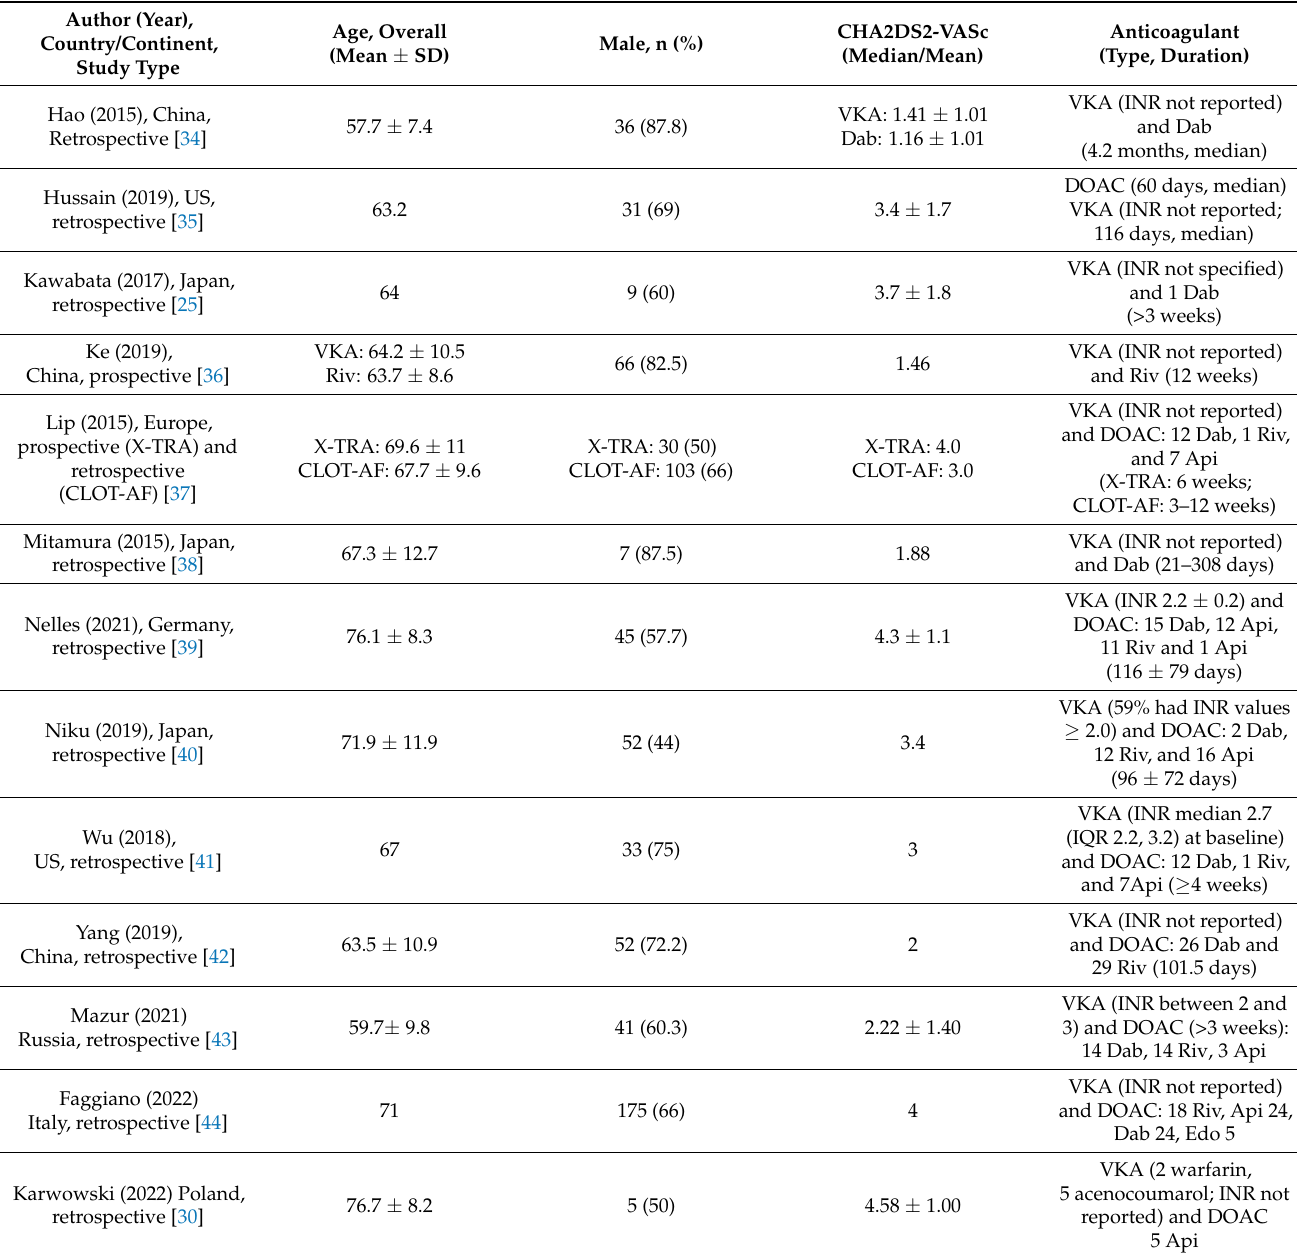
Table 2. Baseline characteristics of included studies for systematic review and meta-analysis of LAAT resolution in patients under VKA or DOAC